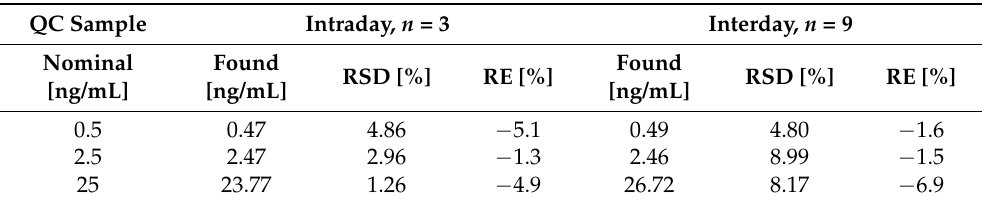
Table 4. Precision (%RSD) and accuracy (%RE) of the developed SPE–UHPLC–MS/MS method from the analysis of QC samples in pooled